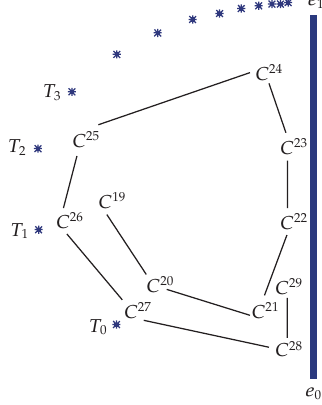
of the Cantor function C . n ∈ N